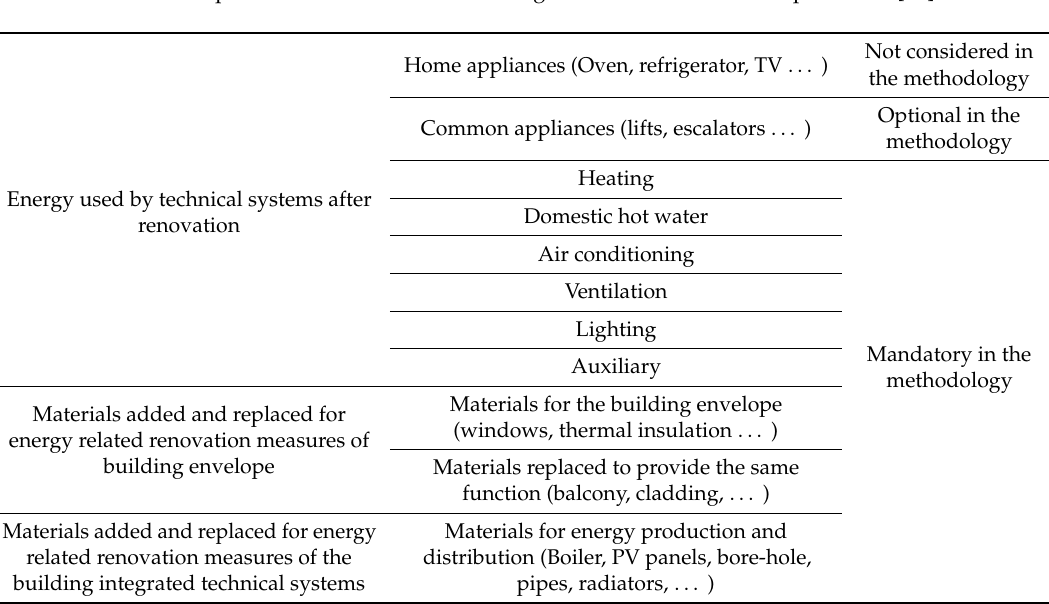
Table 1. Aspects to be included in a building renovation. Source: Adapted from